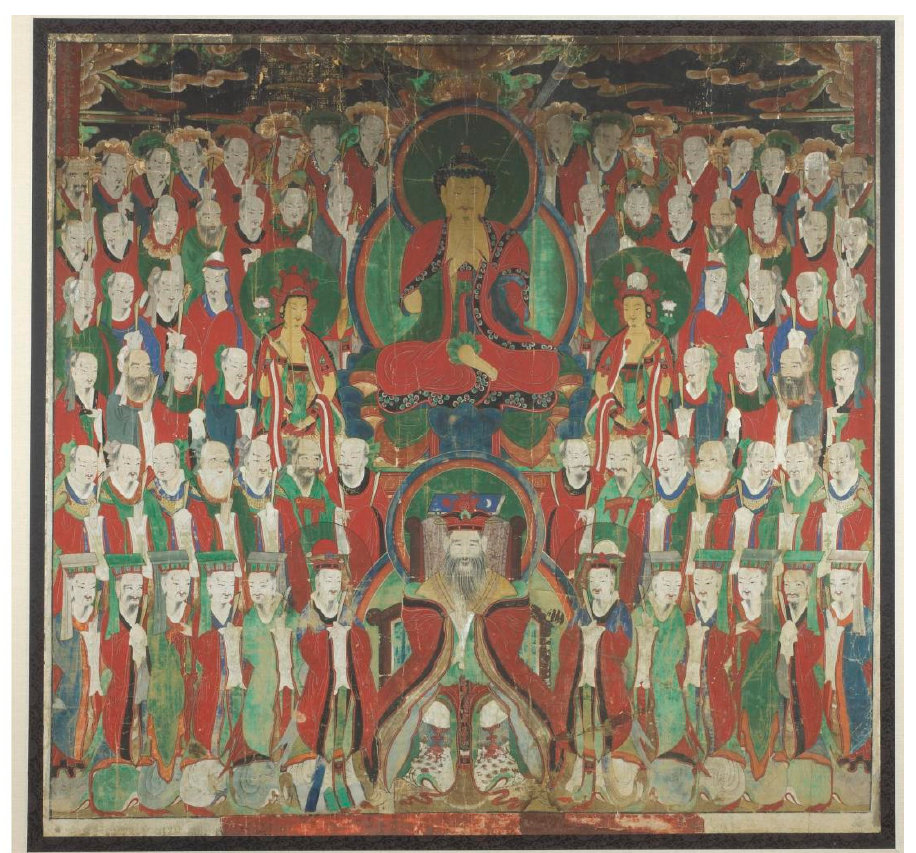
Figure 13. Painting of the Tejaprabh ā Buddha (Chisong Gwangbul) together with the North Pole star (Pukkuk song), British Museum, Mineral colors on coarse silk, From Korea, 136 × 139.6. Dated 1850–1860.